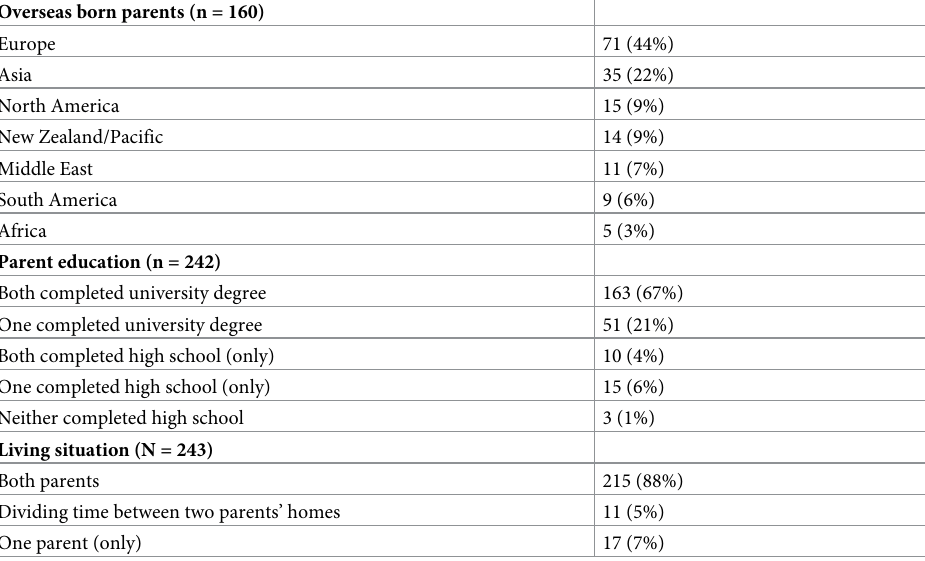
Table 1. Demographic information (Time